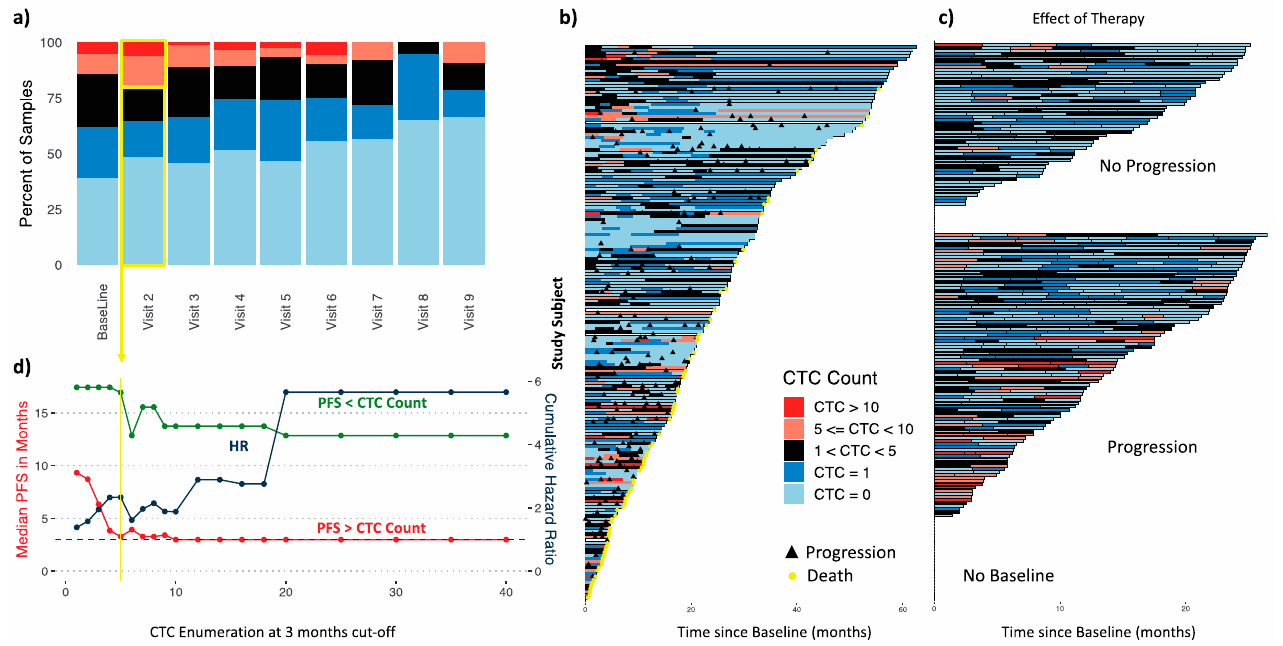
Figure 1. CTC count distribution. ( a ) Range of CTC counts per ~9.5 mL of blood across time points. ( b ) Swimmer plots of CTC counts demonstrate that enumeration is prognostic. ( c ) Swimmer plots of CTC count from cases that progressed and those that did not progress demonstrate the effect of therapy. ( d ) CTC enumeration at 3 months confirms ≥ 5 CTCs/9.5 mL of blood as the most relevant cutoff. Median PFS for patients above (green) and below (red) each CTC threshold (left y axis) and associated hazard ratio (blue, right y axis, dashed blue line HR = 1). CTC, circulating tumor cell; HR, hazard ratio; PFS, progression-free survival.